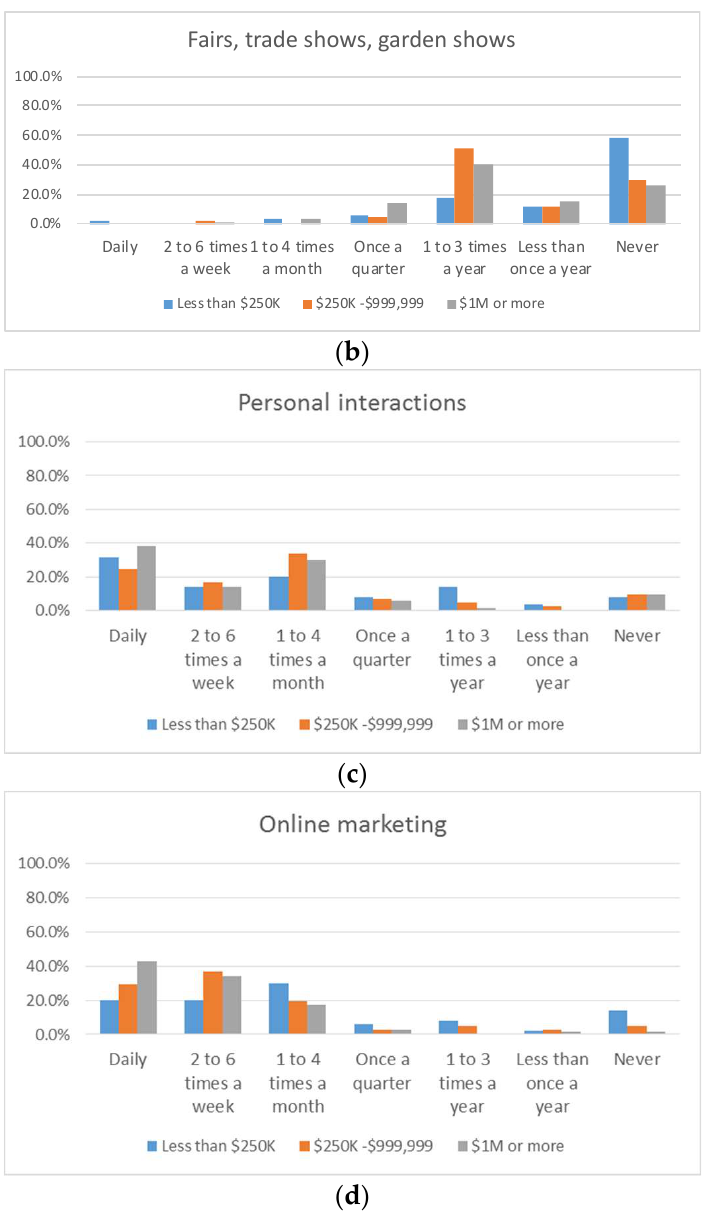
Figure 1. Frequency of use of various traditional marketing venues by ornamental horticulture industry respondents in the study questionnaire: ( a ) print advertisements, ( b ) fairs/trade or garden shows, ( c ) personal interactions, and/or ( d ) online marketing. Categorized by 2014 sales: less than $250,000 ( n = 50); $250,000–$999,999 ( n = 41); and $1 million or more ( n =